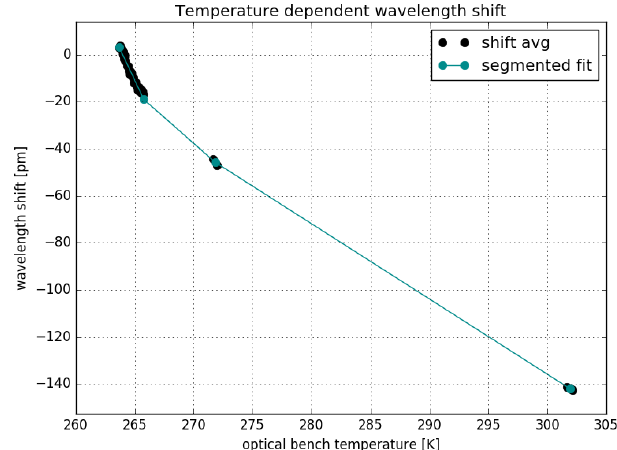
Figure 14. Average OPB temperature during irradiance measure- ments versus orbit number. The temperature can be seen to be steadily increasing during the mission lifetime and then decreasing at the end as a result of the new thermal configuration.